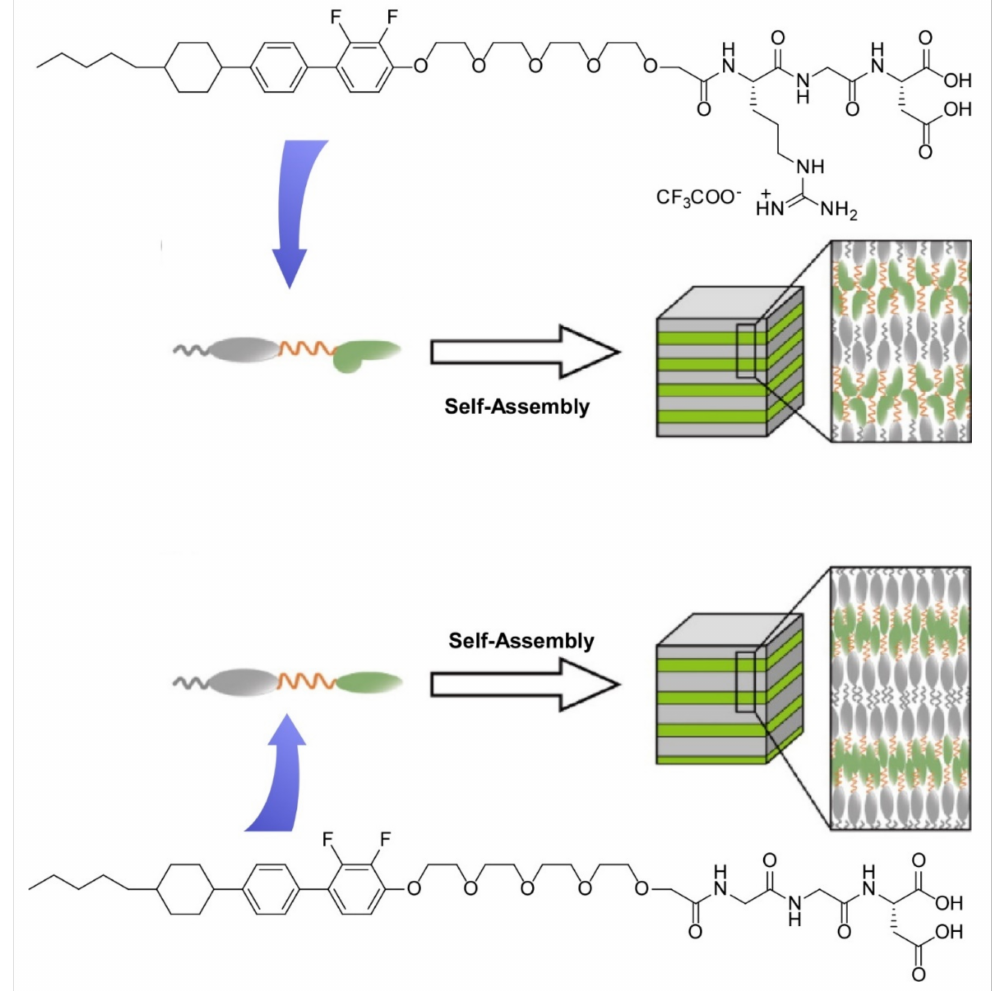
Figure 16. Steric effects of peptide side chains in molecular assemblies of liquid crystalline phase through synthesizing mesogens with arginine-glycine-aspartic acid part (top) and glycine-glycine- aspartic acid part (bottom). Reprinted with permission from Reference [157]. Copyright 2021 Chemical Society of